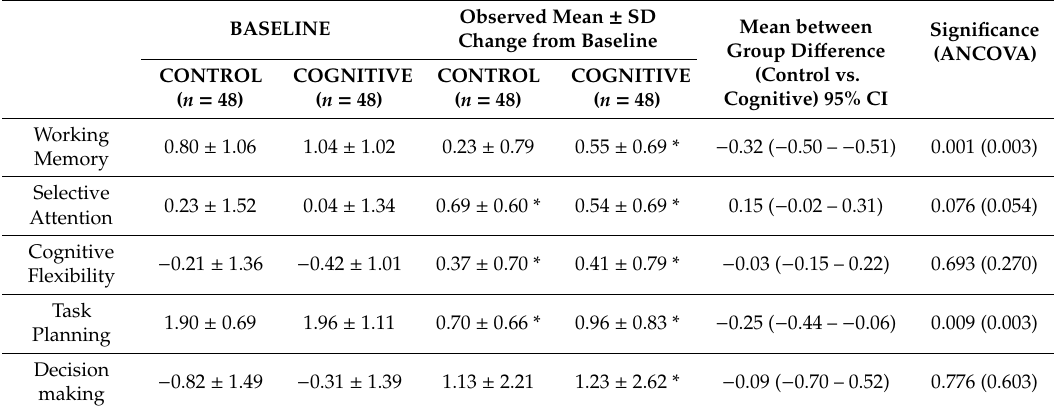
Table 2. Three-month change estimates for executive function variables by